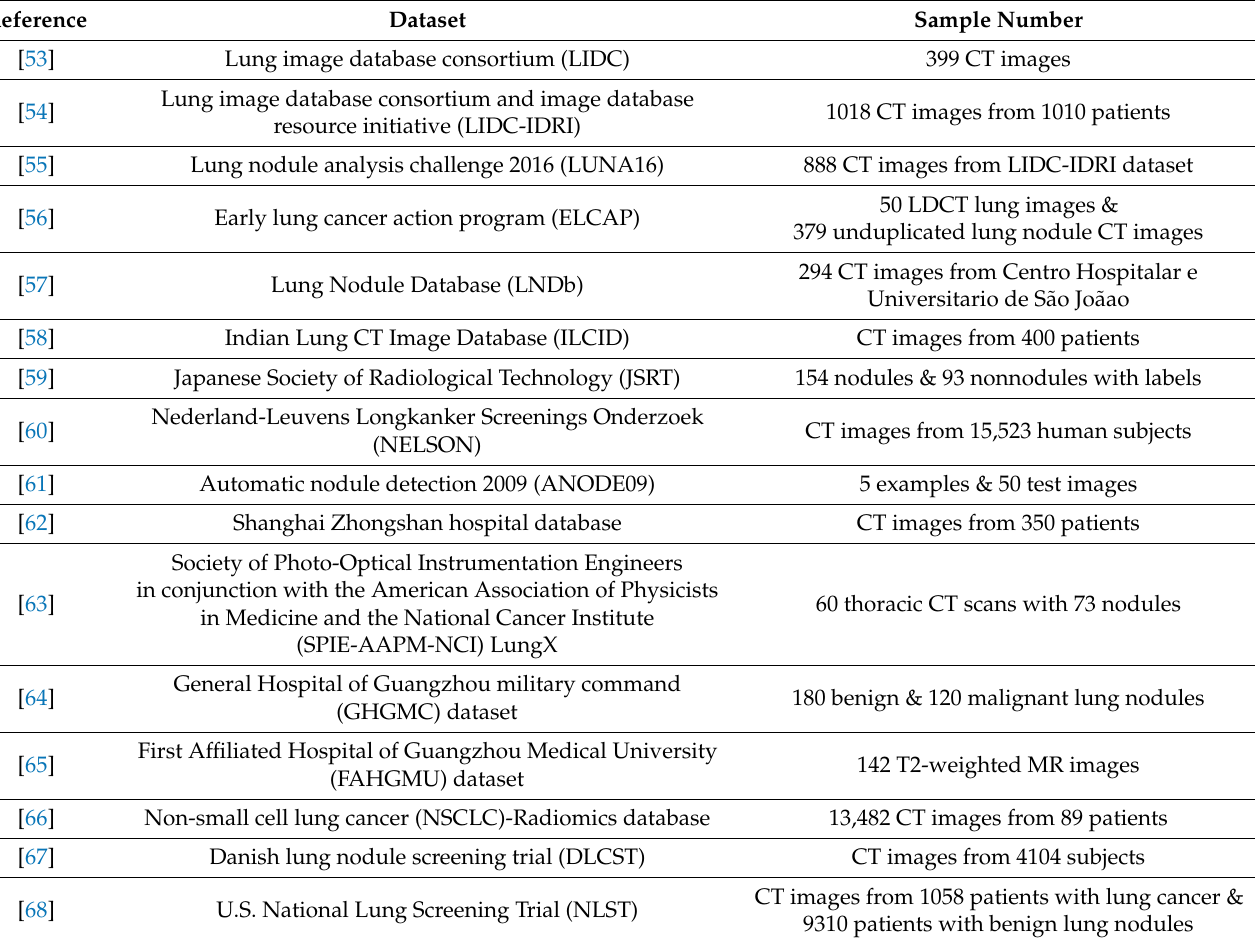
Table 1. Lung image